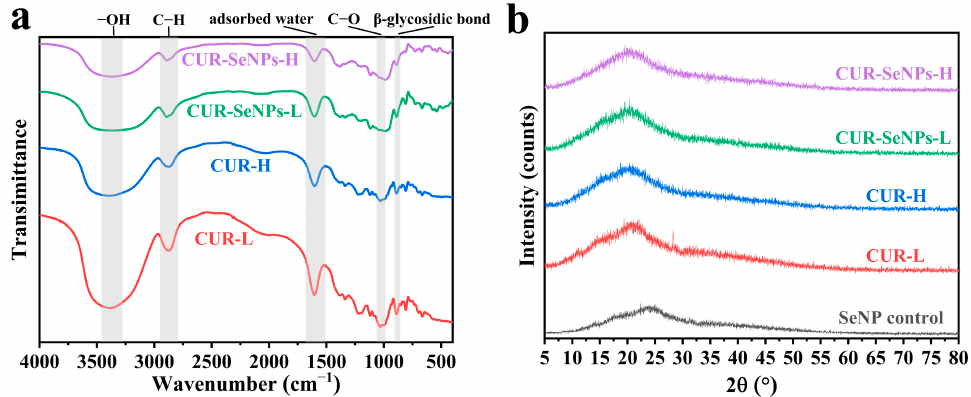
Table 1. Hydrodynamic-diameter distributions of CUR-SeNP samples.